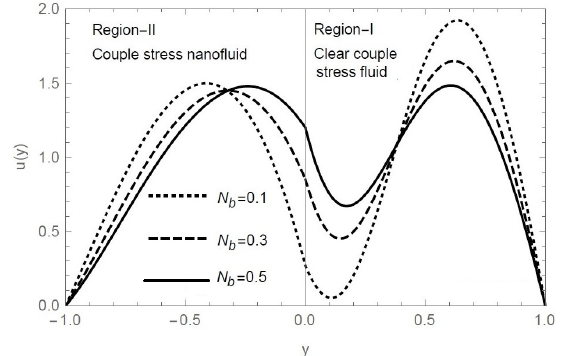
Figure 3: The influence of Brownian motion parameter N b on fluids flow keeping λ 1 = 50, Pr i = 5, h = 1, ξ i = δ i = 0.1, Γ i = 1, N t = 0.01 and µ = K = 0.5 .